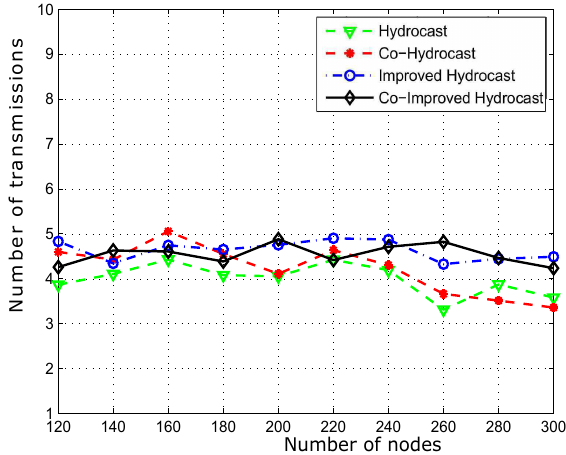
Figure 19. Number of transmissions for data packet